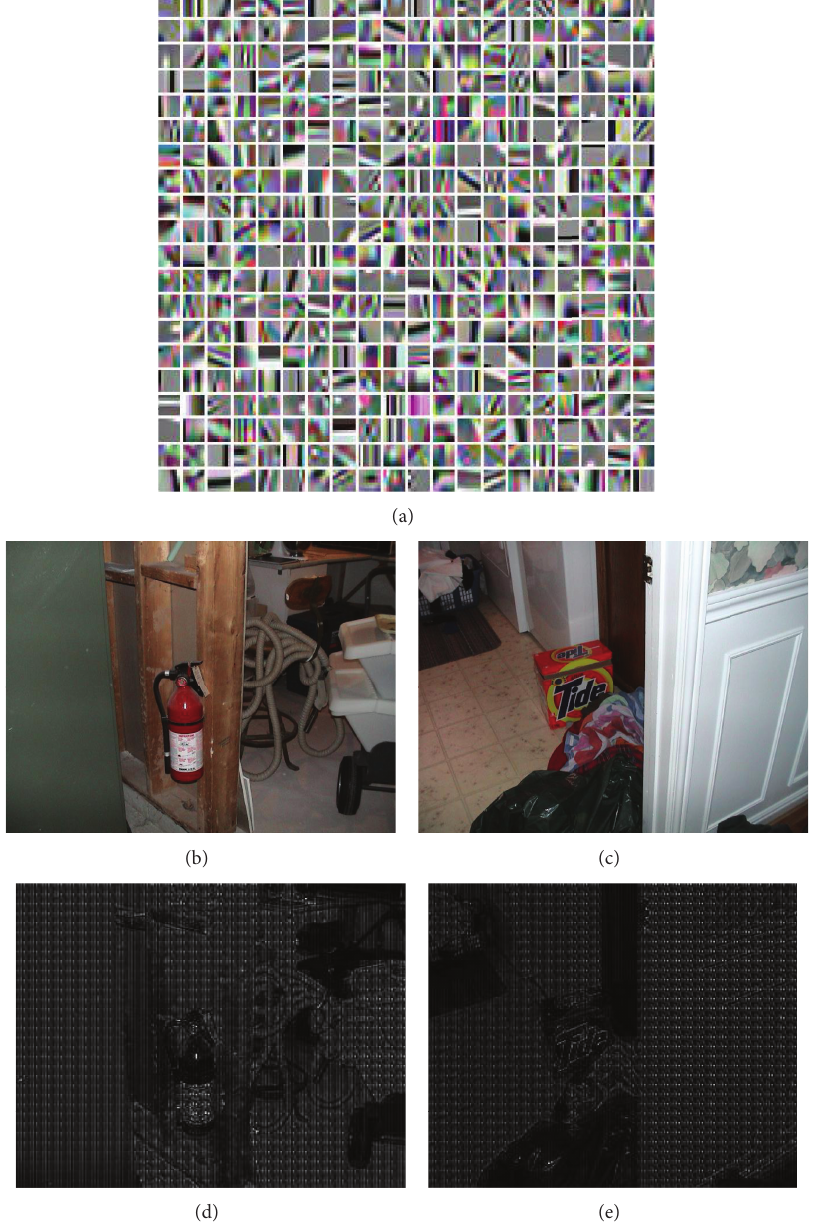
Figure 8: The fixed learned dictionary and the information lost by using such dictionary. (a) Fixed learned dictionary. ((b)-(c)) The input images. ((d)-(e)) The information lost by using dictionary given in